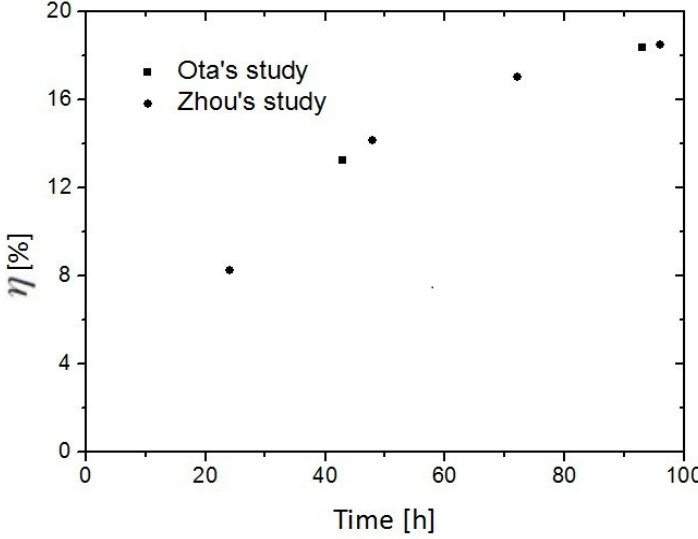
Figure 6. CH ratios replaced from the hydrate of the two different experiments. 4